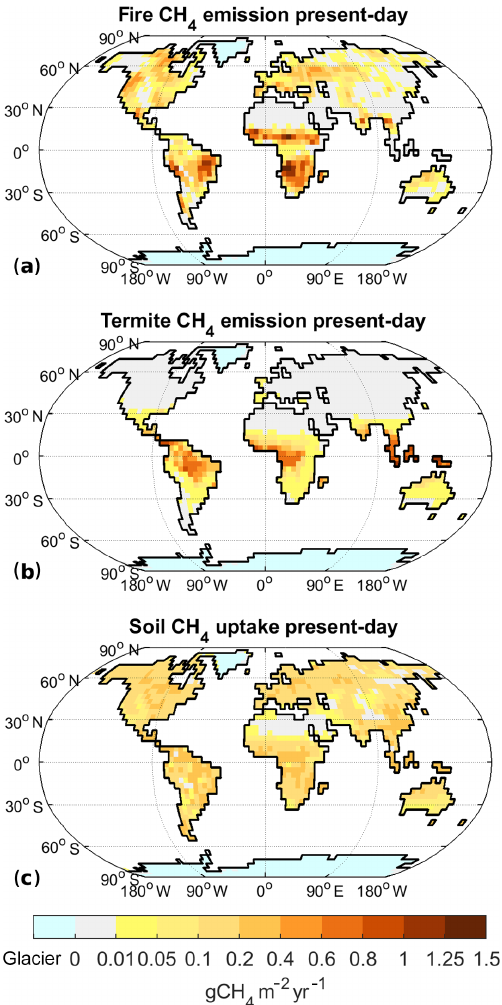
Figure B2. Model results for present-day climate (2000–2009): an- nual emissions of CH 4 from fires (a) , termites (b) , and annual soil uptake of CH 4 (c) . In comparison to other fluxes, soil uptake has the opposite direction